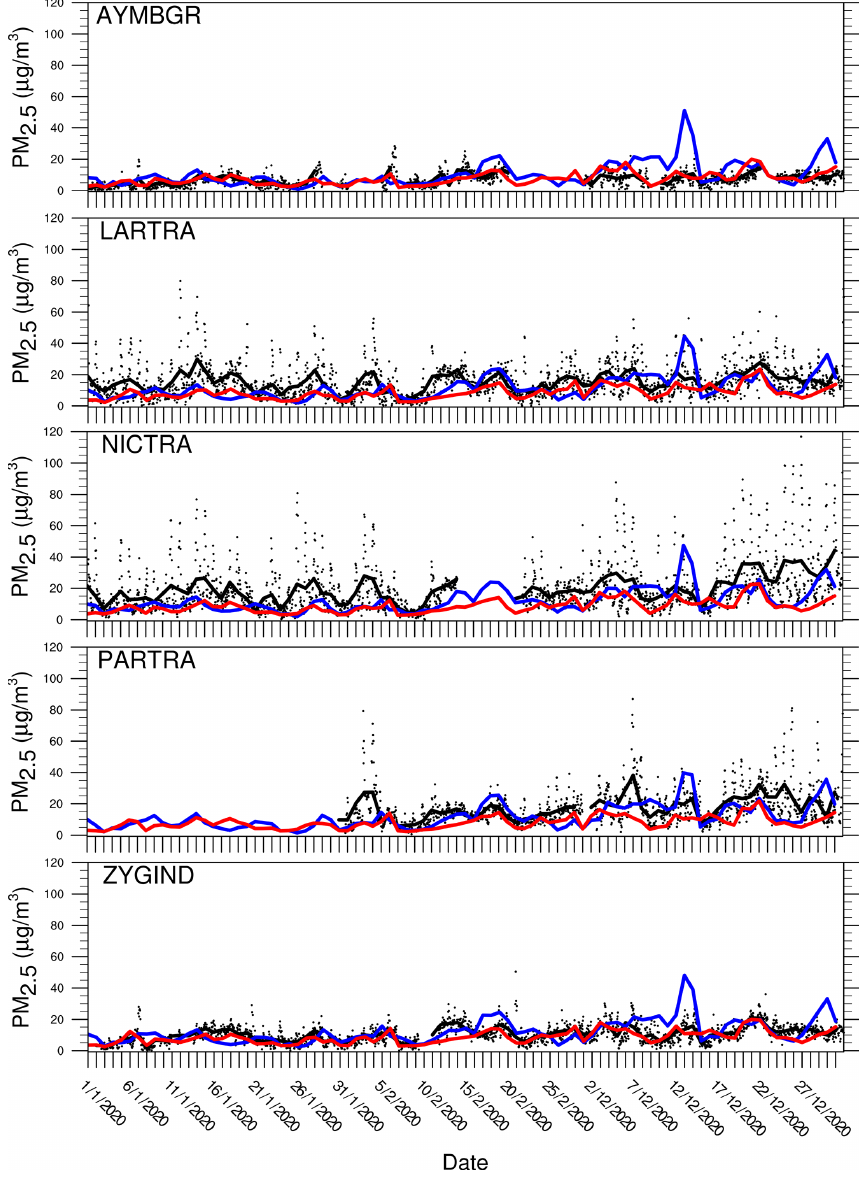
Figure 8. Observed hourly PM 2 . 5 concentrations (black dots) and daily average PM 2 . 5 concentrations from observations (black lines), WRF-Chem (blue lines), and CAMS (red lines) during